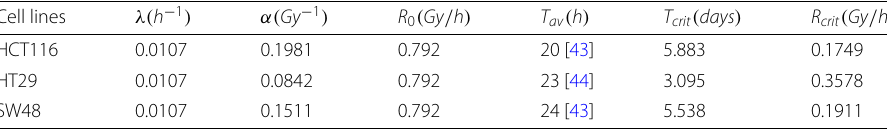
Table 4 Critical times ( T crit ) and dose rates ( R crit ) for HDR– 90 Y RNT Cell lines